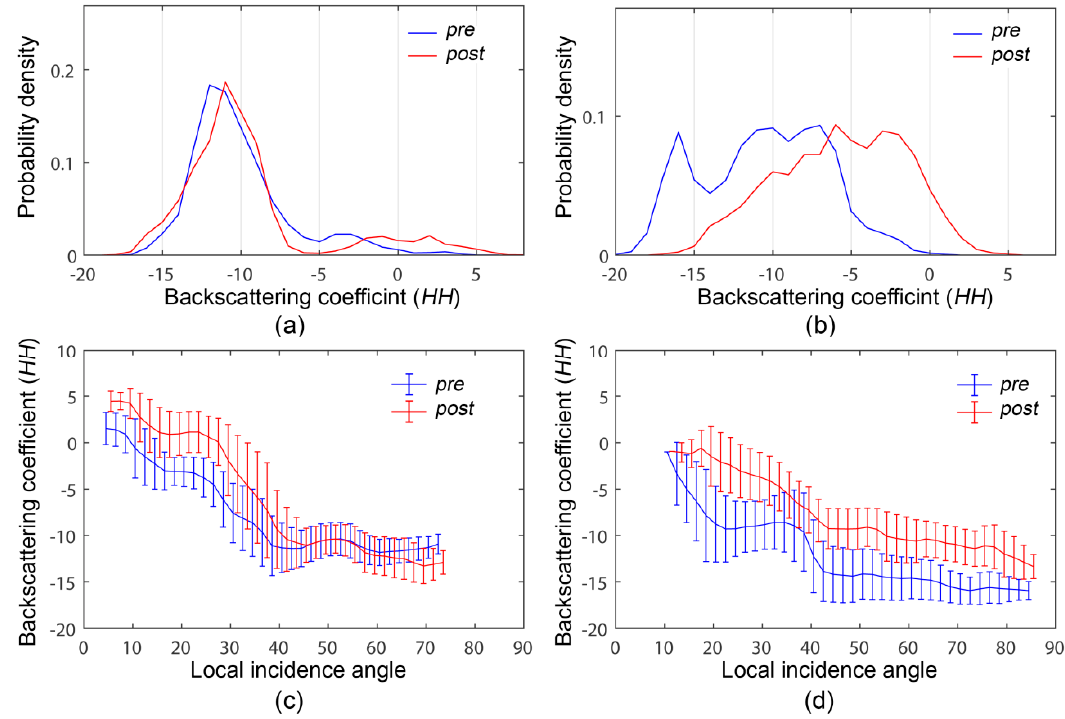
Figure 3. Upper row: Changes of the histogram of the HH-polarization backscattering coefficient calculated over the selected landslide sites in ( a ) forested and ( b ) non-forested areas. Lower row: The HH-polarization backscattering coefficient of the ( c ) forested and ( d ) non-forested areas in relation to the local incidence angle.